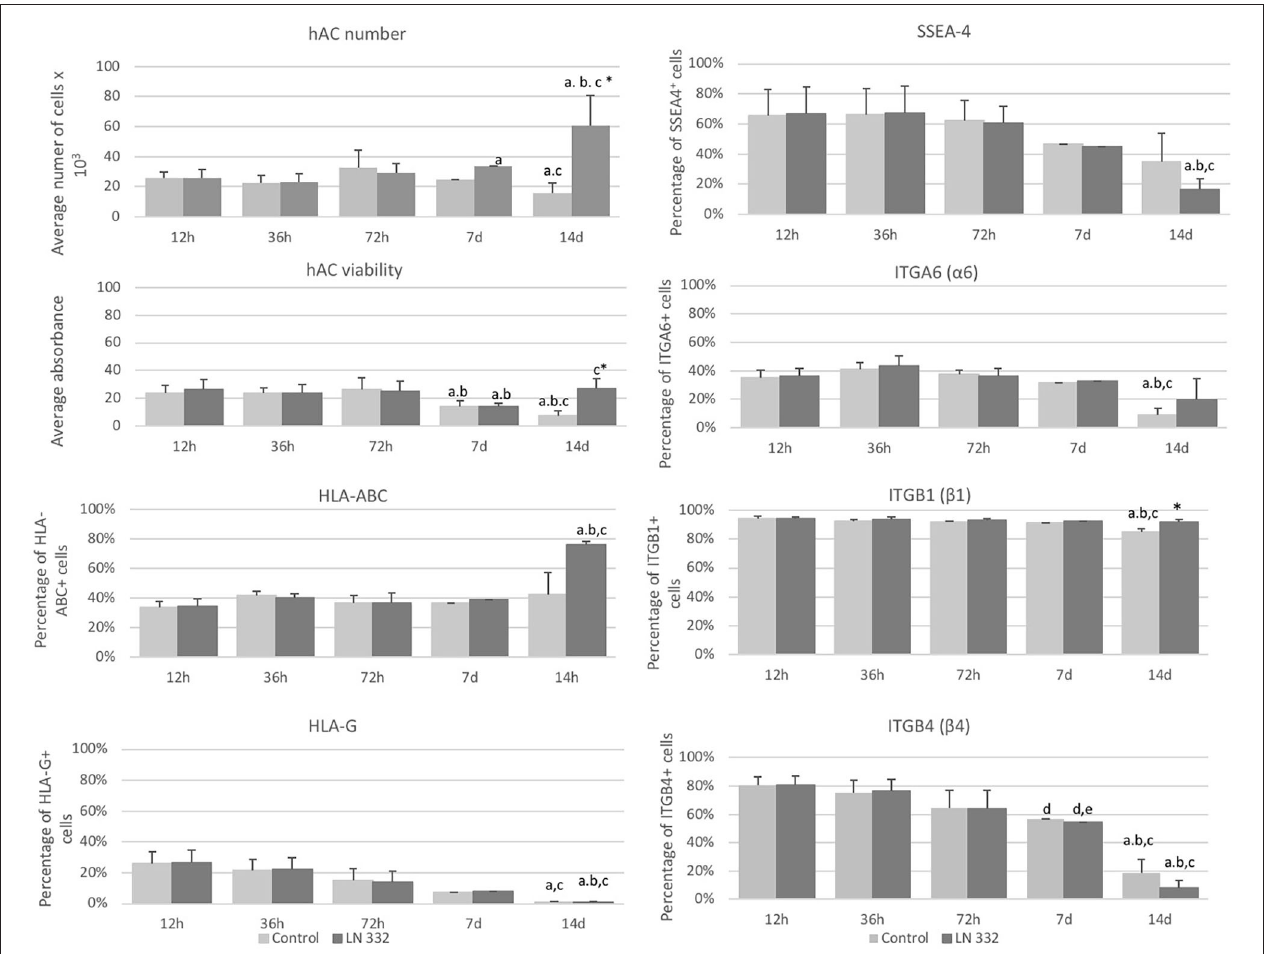
FIGURE 3 | Average number and viability of amniotic cells cultured on uncoated (control) and laminin 332-coated (LN-332) plates. Differences statistically significant as compared to: *appropriate control; a 12 and 36h; b 72h; c 7 days; p < 0.05; n = 5. Number of SSEA-4 + , HLA-ABC + , HLA-G + , ITGA6 + , ITGB1 + , and ITGB4 + cells among hAC cultured on uncoated (Control) and laminin 332 (LN-332) coated plates. Differences statistically significant as compared to: * appropriate control a 12h, 36h, and 7 d; b 72h; c 12h; d 36h; p <